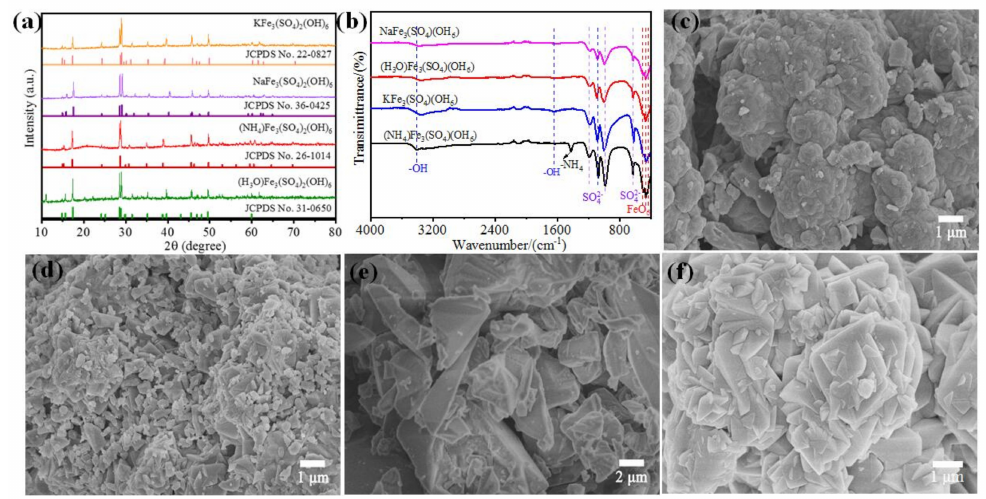
Figure 1. ( a ) XRD patterns and ( b ) FT-IR spectra of various types of jarosite. SEM images of ( c ) KFe 3 (SO 4 ) 2 (OH) 6 , ( d ) NaFe 3 (SO 4 ) 2 (OH) 6 , ( e ) (H 3 O)Fe 3 (SO 4 ) 2 (OH) 6 and ( f ) (NH 4 )Fe 3 (SO 4 ) 2 (OH) 6 .